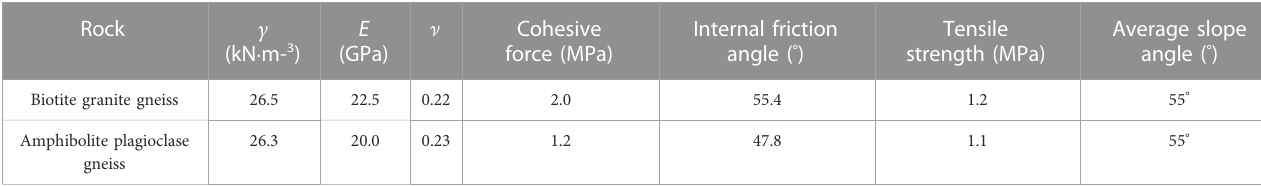
TABLE 5 Physical and mechanical parameters of rock mass (Jiang et al.,